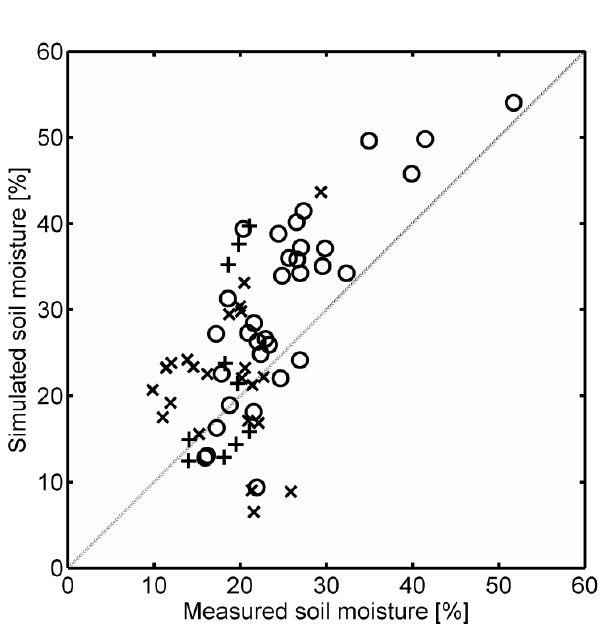
Fig. 8. Estimated versus measured topsoil moisture. The differ- ent symbols correspond to three successive wheat vegetative peri- Figure 8. Estimated versus measured topsoil moisture. The different symbols correspond to three ods: (i) the beginning (“+”) with biomass water content (BWC) be- tween 0 to 5tha − 1 , (ii) the middle (“o”) before senescence starts successive wheat vegetative periods: (i) the beginning (‘+’) with biomass water content (BWC) with BWC between 5 and 65tha − 1 , and the end (“ × ”) associated to leaf senescence. between 0 to 5 t ha -1 , (ii) the middle (‘o’) before senescence starts with BWC between 5 and 65 t.ha - 1 , and the end (‘×’) associated to leaf senescence.